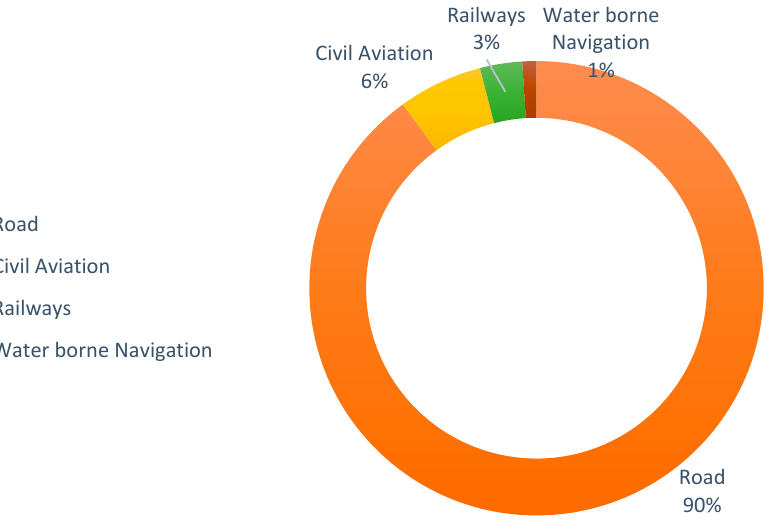
Figure 2. Pollutant emissions by various transportation sectors of India [23].